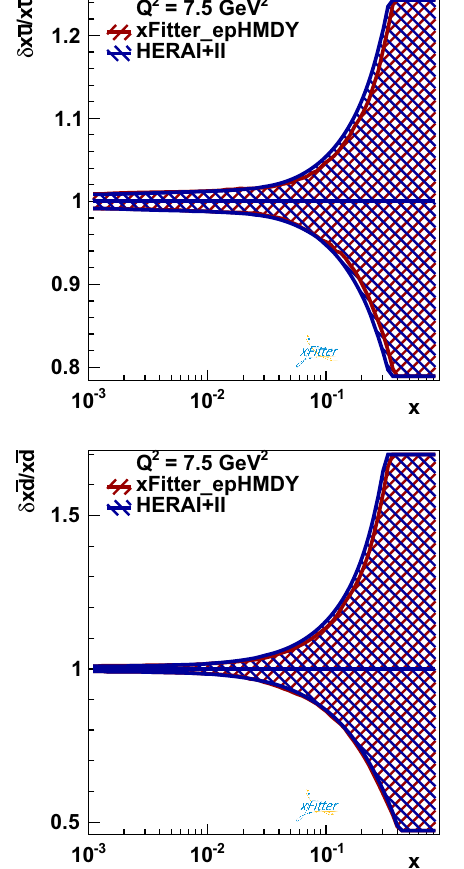
Fig. 7 TheimpactoftheATLAShigh-mass8TeVDrell–Yanmeasure- ments on the x ¯ u and x ¯ d sea-quark PDFs at the input parametrisation scale Q 2 = 7 . 5 GeV 2 . The results are shown normalised to the central value of xFitter_epHMDY